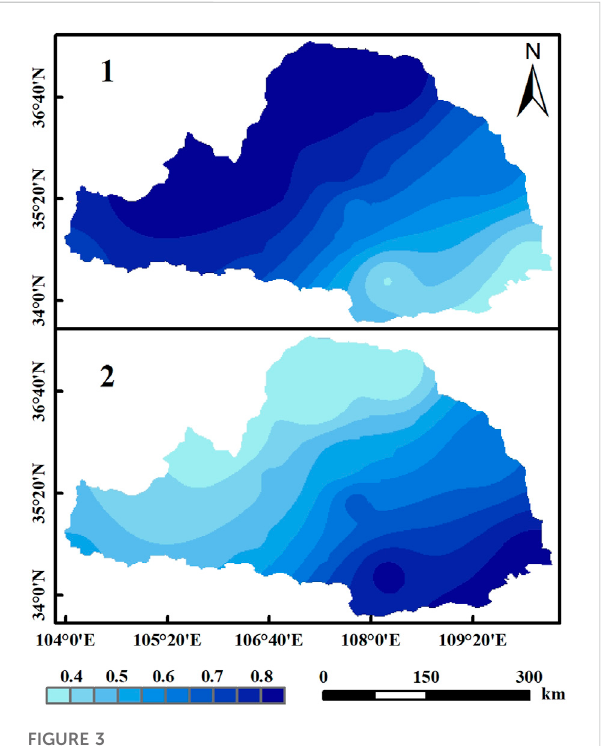
FIGURE 3 Spatial distribution of the principal